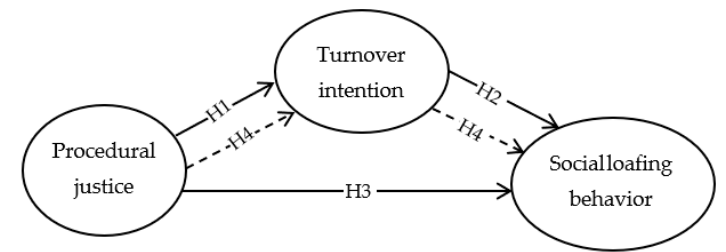
Figure 1. The theoretical